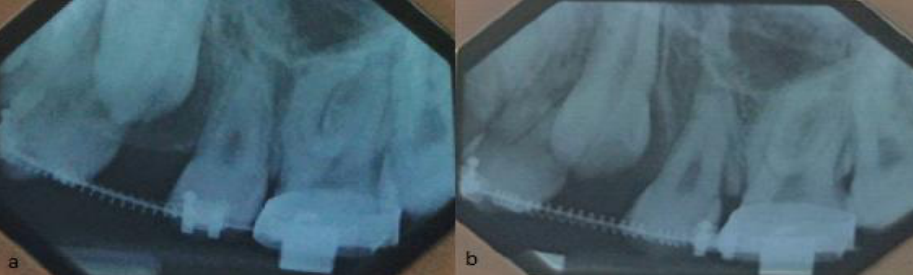
Figure 8. The periapical view of upper left canine during orthodontic alignment at the age of 13 (a) and 14